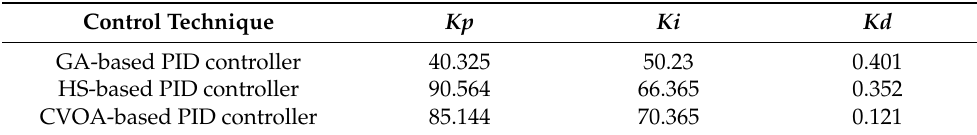
Table 3. The obtained parameters of each control technique.